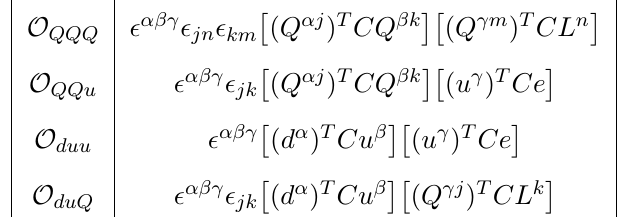
Table 12. 2HDM: Baryon Number Violating 4 [4 a distinct Hermitian Conjugate. Here, C = i(cid:13) 2 (cid:13) 0 in Dirac representation. Here (cid:11); (cid:12); (cid:13) are SU(3) indices and j; k are SU(2)